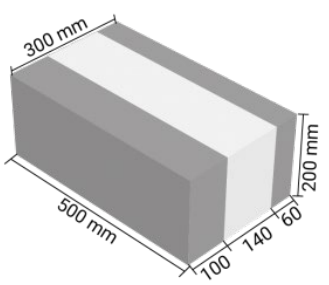
Fig. 3. Industrially produced sandwich foam concrete block with EPS thermal insulation (Sample 6).